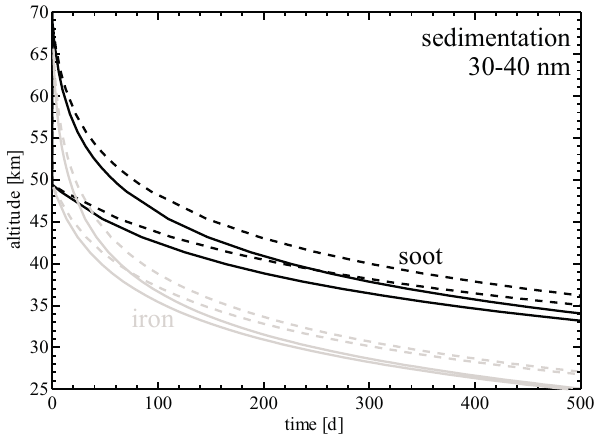
Fig. 9. Sedimentation of soot (ρ = 2240kg / m 3 ) and iron (ρ = 7900kg / m 3 ) particles with 30 and 40nm radius (dashed line and solid line, respectively). Initial altitudes at t = 0 are 50 and